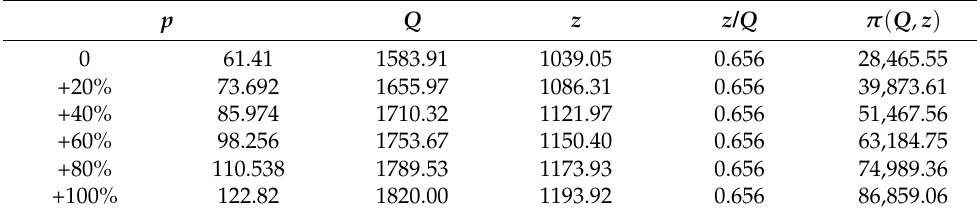
Table 4. The results for various selling prices p .